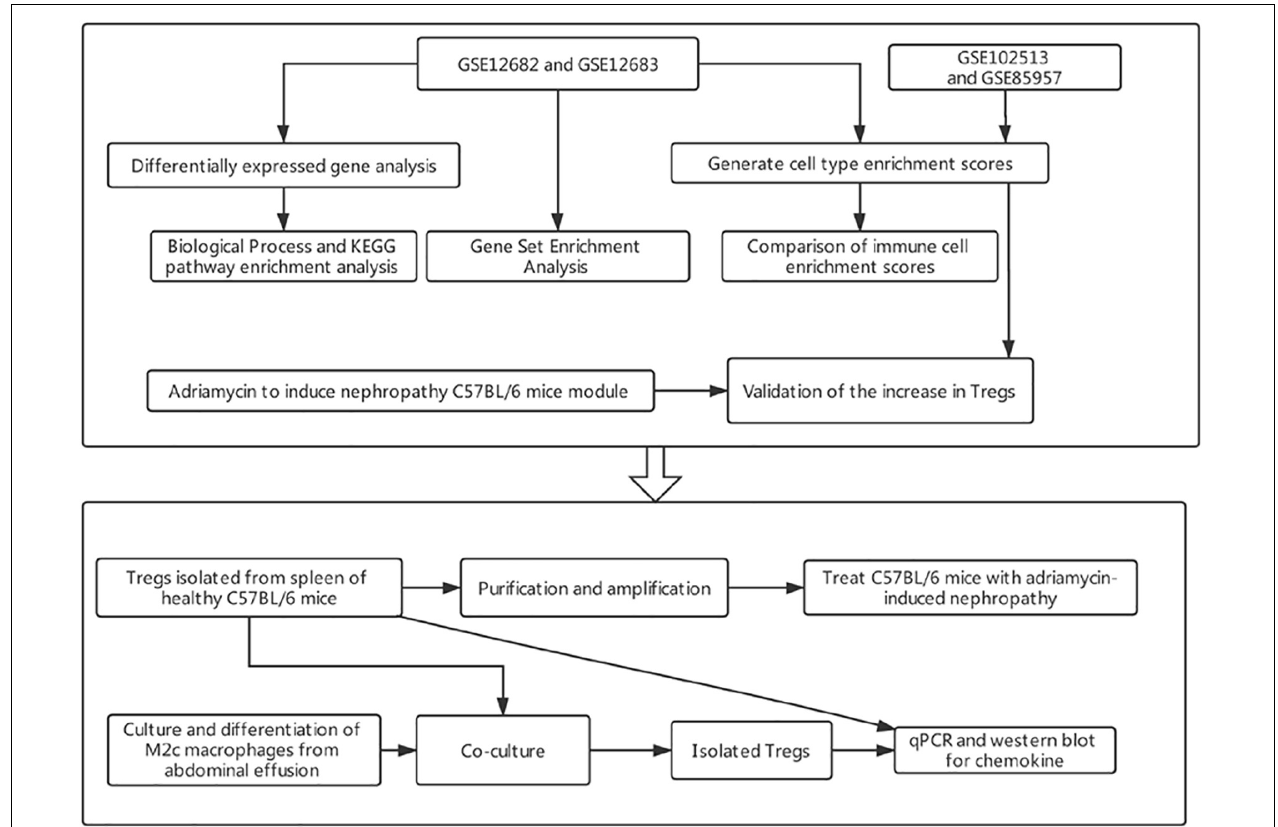
FIGURE 1 | The work flow of the present study. KEGG, Kyoto Encyclopedia of Genes and Genomes.